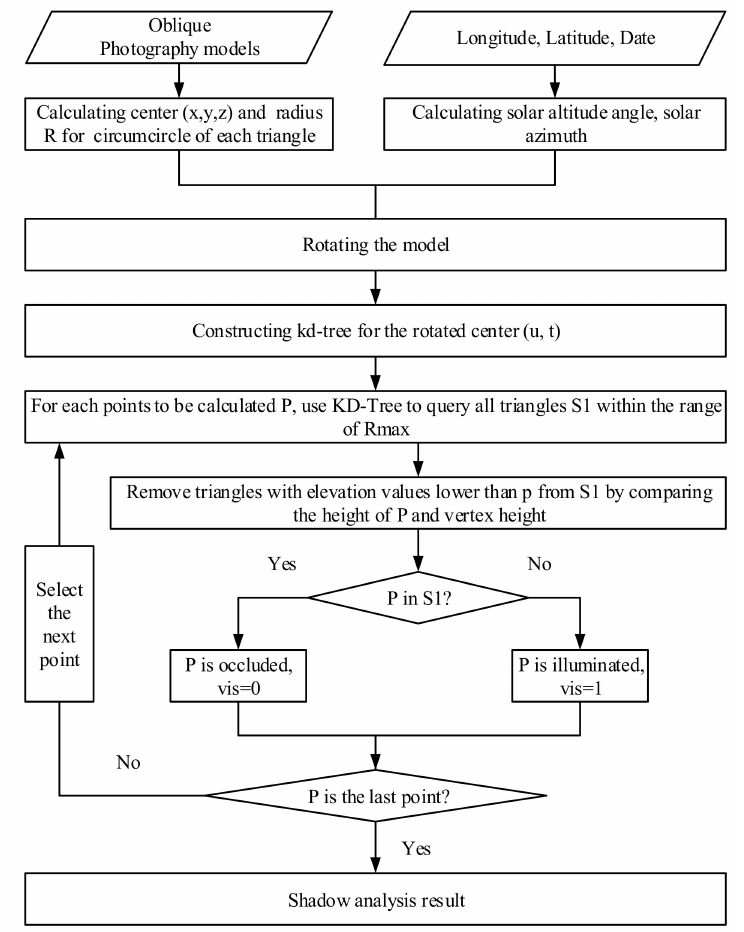
Figure 4. The flowchart of the hierarchical shading